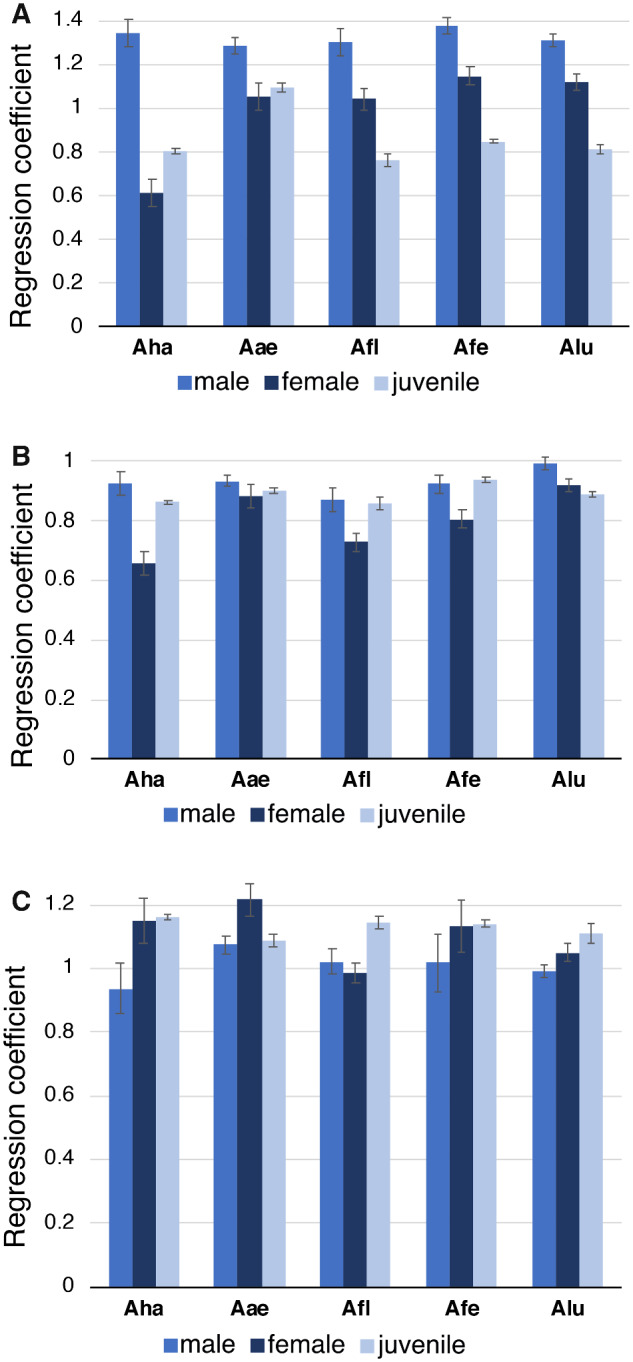
Bar graph of regression coefficients and standard errors for males, females, and juveniles for (A) HW, (B) HL, and (C) trunk (AG) length regressed against SVL, for the 5 species of Aneides examined. Note that male and female A. hardii have the greatest difference in regression coefficients for HW vs. SVL and the other species show reduced dimorphism. Aha: A. hardii; Aae: A. aeneus; Afl: A. flavipunctatus; Afe: A. ferreus; Alu: A. lugubris.